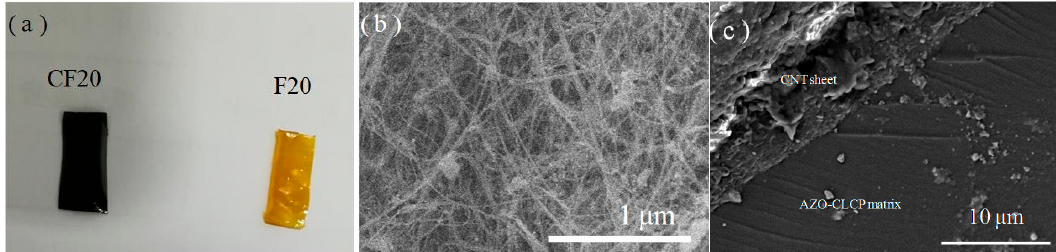
nanocomposite film (CF20). Size of the films: 12 mm × 6 mm × 20 µm; ( b ) A SEM image of the CNT